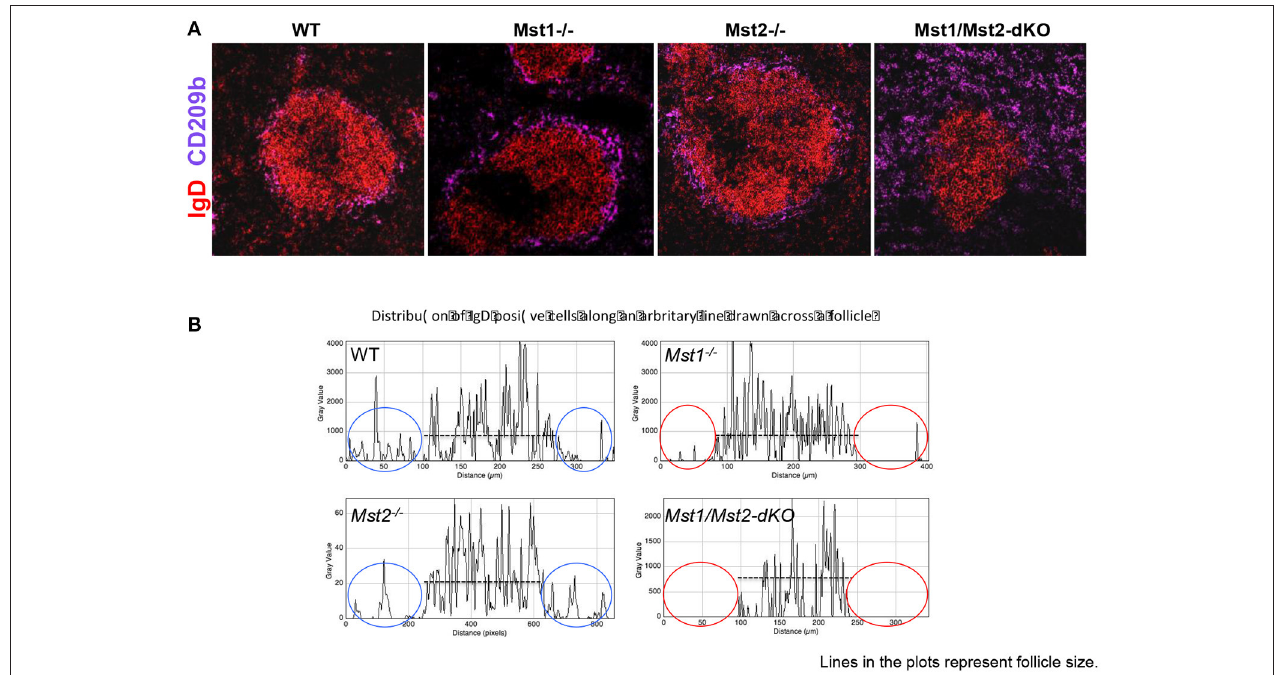
FIGURE 4 | Disrupted architecture of the marginal compartment in Mst1/Mst2-dKO mice. (A) Immunofluorescence on spleen sections shows an intact MZ macrophage ring in Mst1 − / − and Mst2 − / − mice but a disrupted MZ macrophage compartment in Mst1/Mst2-dKO mice. IgD is in red and CD209b is in magenta. (B) Histogram plots generated on Zen software from spleen sections of Mst1 − / − , Mst2 − / − , Mst1/Mst2-dKO mice, and WT controls showing the distribution of IgD + cells along a line drawn across the follicle extending into the red pulp. The red ovals highlight the lack of IgD + B cells outside the follicles in Mst1 − / − and Mst1/Mst2-dKO mice. (Data are representative of spleens sectioned and analyzed from 3 mice of each